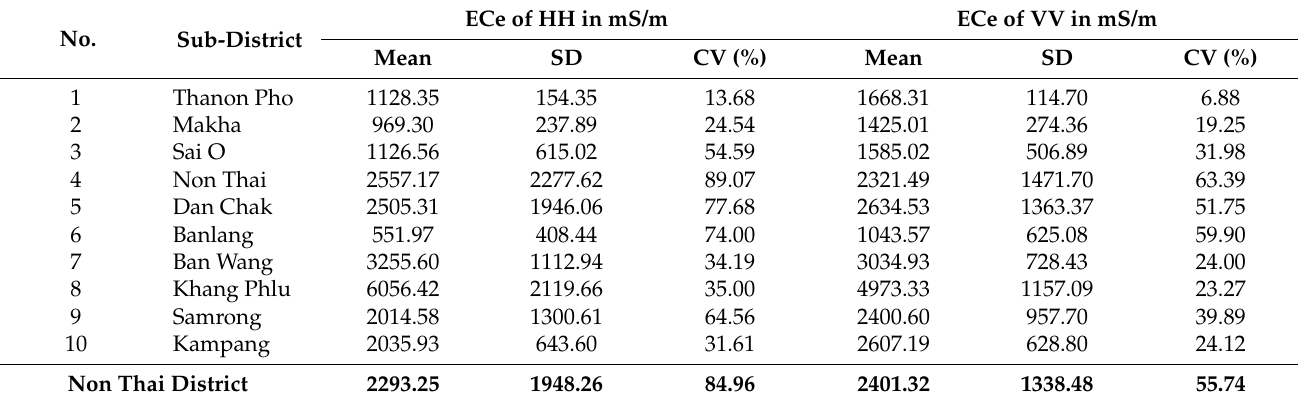
Table 12. Statistical data of soil salinity prediction using OCK of two modes by sub-district.